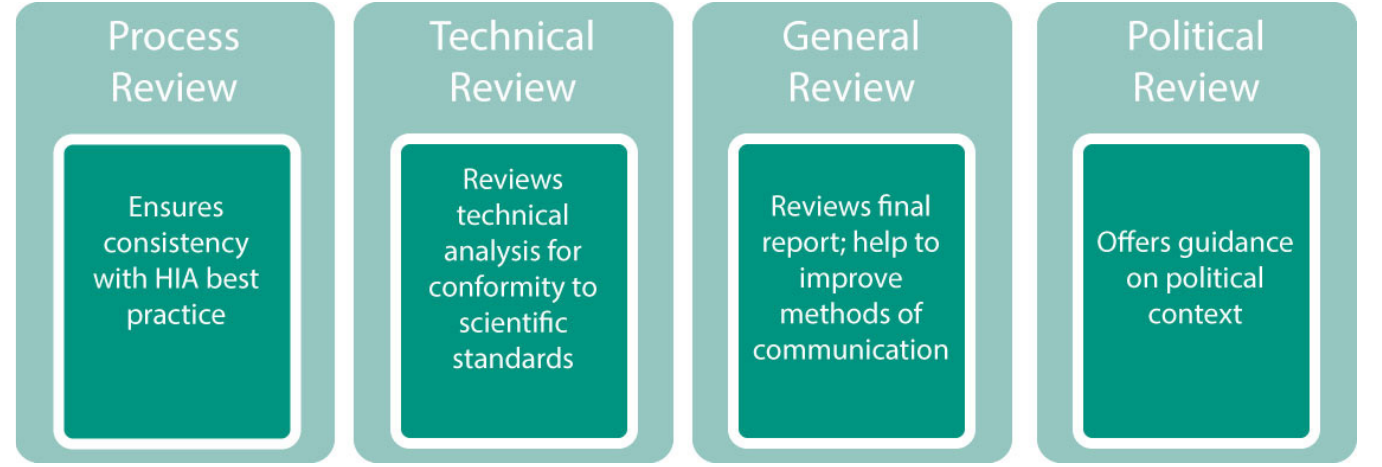
Figure 2: Typology of HIA Peer